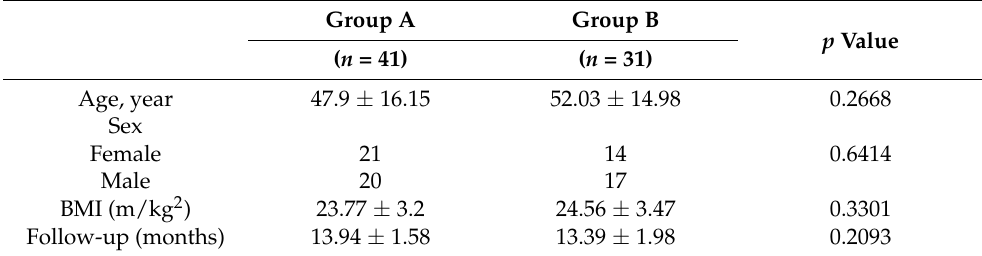
Table 2. Patient